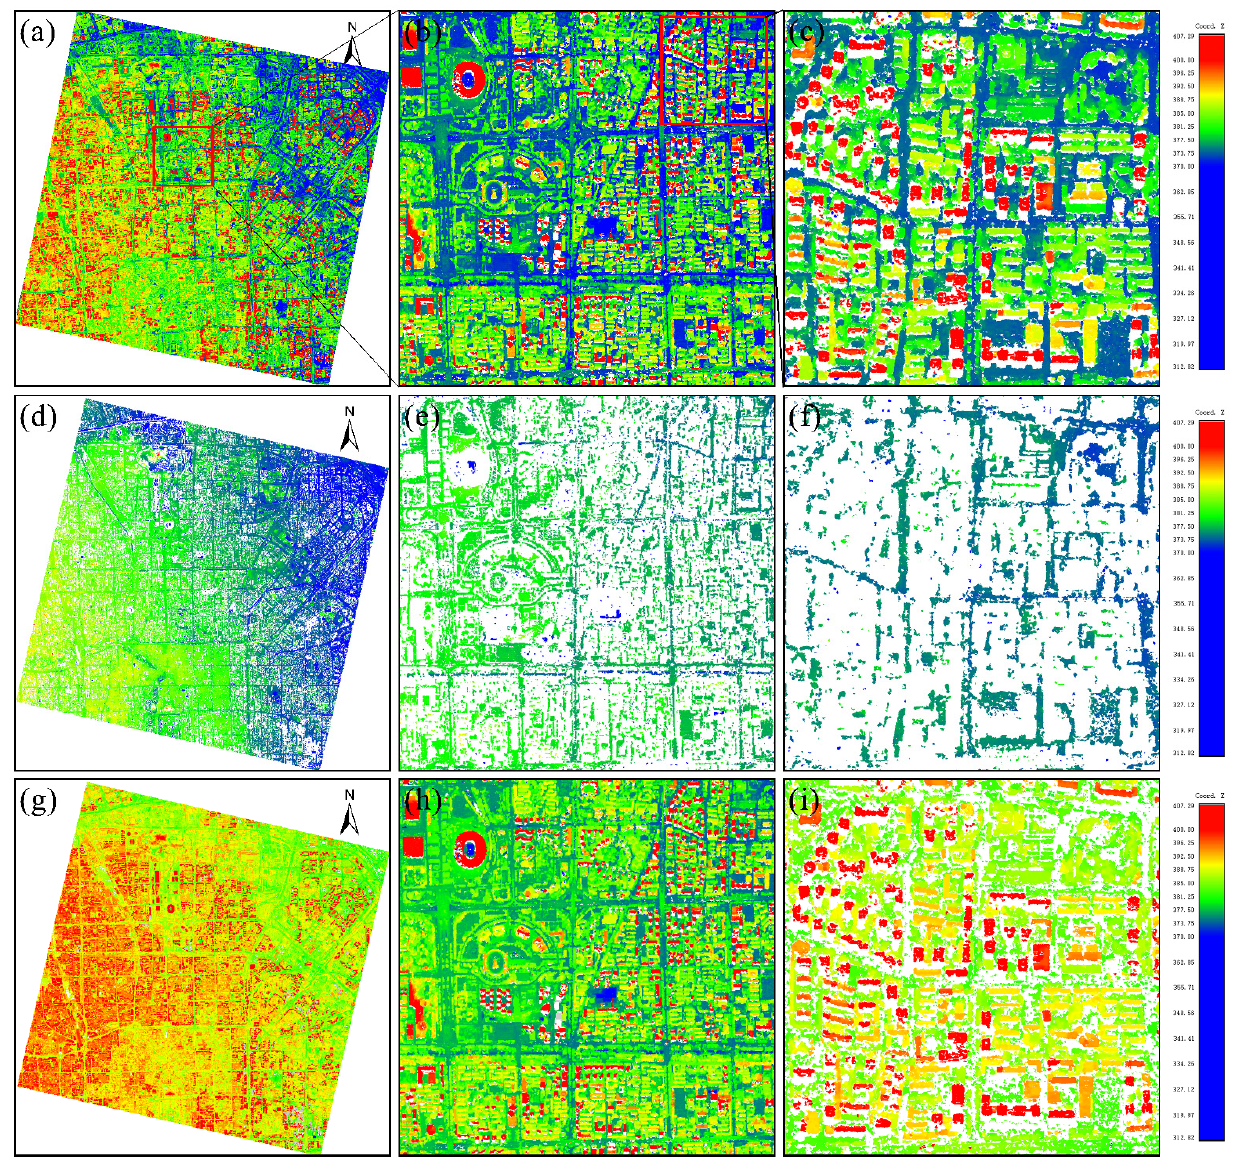
Figure 11. Point cloud generation results in the study area: ( a–c ) point cloud results; ( d–f ) ground point results; ( g–i ) off- ground point cloud results.